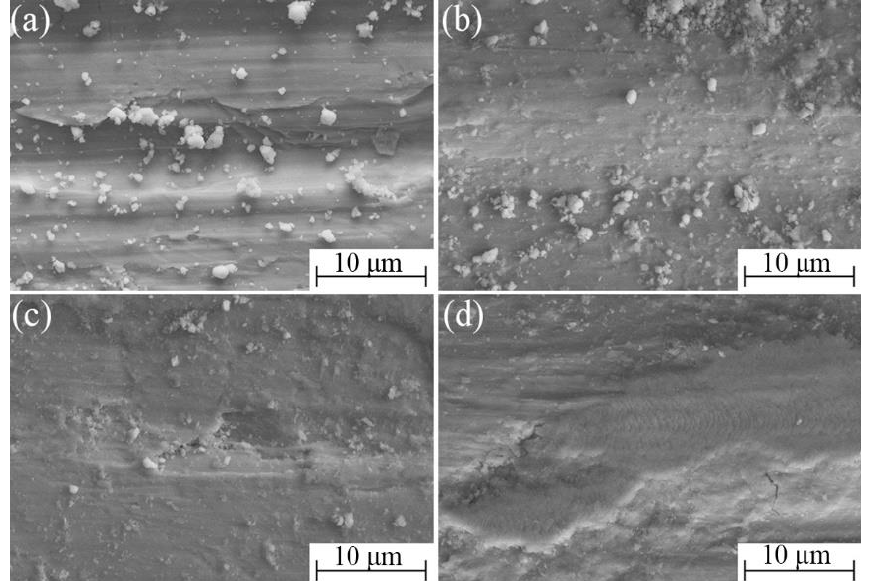
Figure 8. Surface morphology of the grinding cracks of PM-fabricated Ti-10Nb-xSn alloys: ( a ) Ti-10Nb, ( b ) Ti-10Nb-3Sn, ( c ) Ti-10Nb-5Sn, ( d ) Ti-10Nb-8Sn.